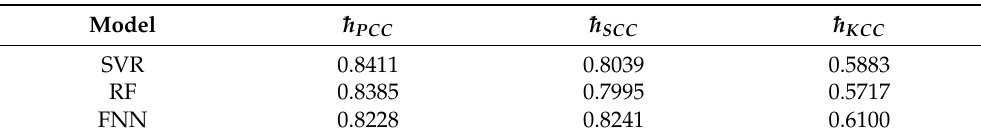
Table 1. The performance of our proposed PM 2.5 concentration estimation algorithm based on SVR, RF, and FNN on the AQID.